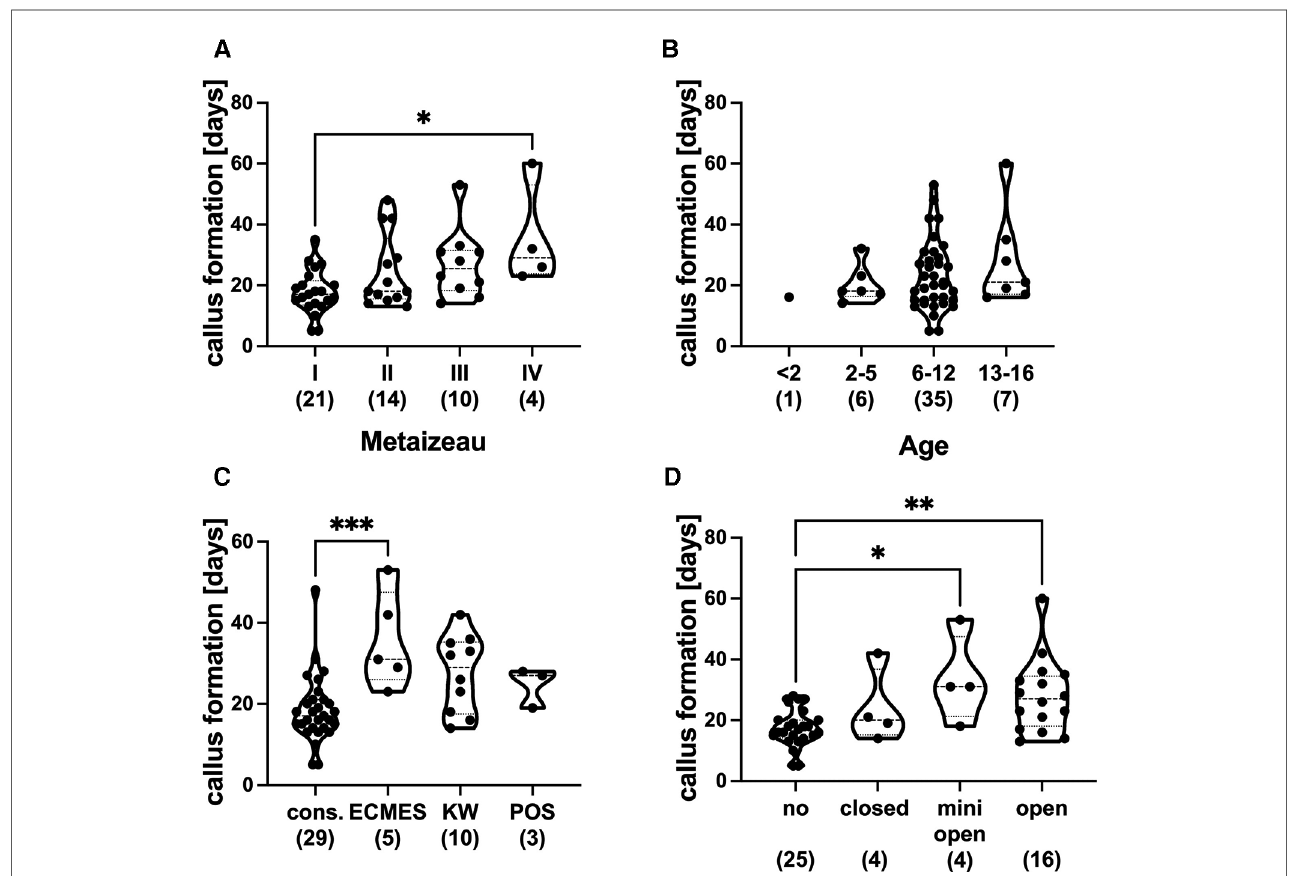
FIGURE 4 ( A ) Callus formation in days with regard to metaizeau classi fi cation (I – IV). ( B ) Callus formation in days depending on age groups in years. ( C ) Callus formation in days with regard to treatment strategy (cons.=conservative treatment and without stabilization, ECMES=embrochage centromedullaire elastique stable, KW =K-wire, POS=plate osteosynthesis). ( D ) Callus formation in days with regard to reduction (no, closed, minimal, open). * p <0.01, ** p <0.001, graphical presentation as median with interquartile range, ( ) number of patients in respective